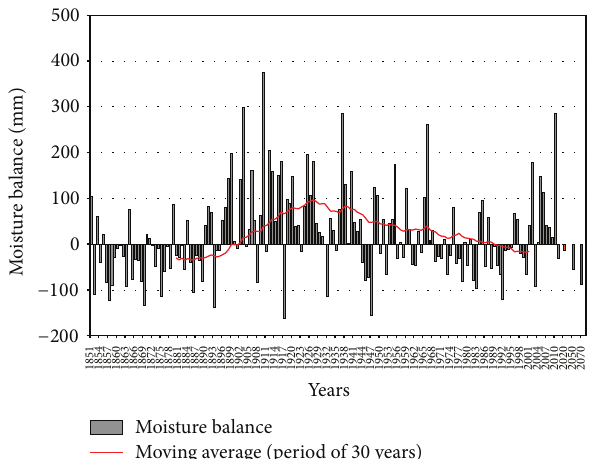
Figure 3: Development of moving averages (30 years) of moisture balance in the area of South Moravian floodplain forests in the periodof1851–2011andpredictionofmoisturebalancefortimehori- zons of 2020, 2050, and 2070 which also represent a 30-year